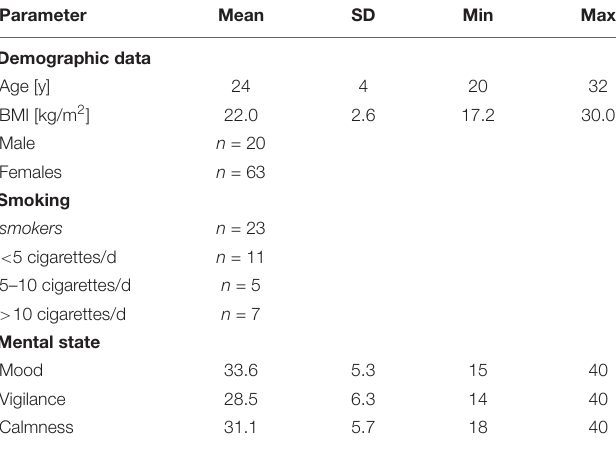
TABLE 1 | Demographic data of the sample including 83 healthy